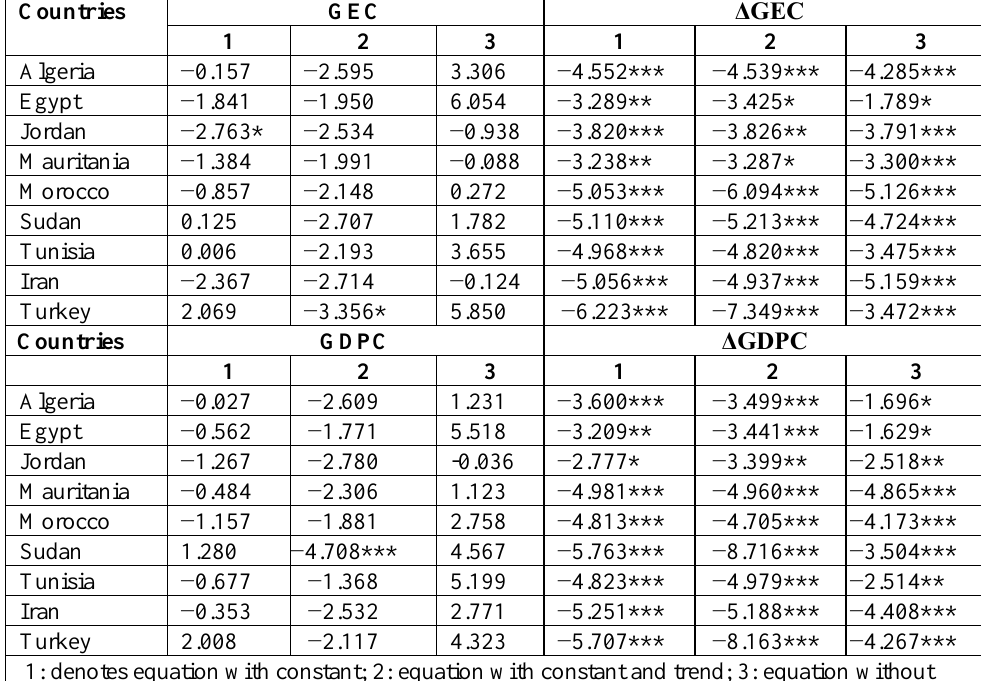
Table 6. Unit Root Test